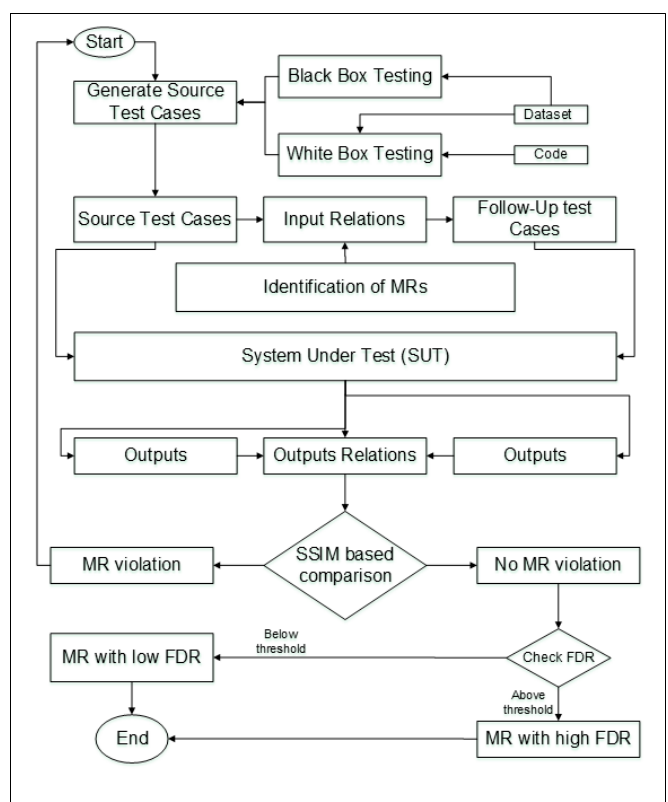
Figure 2. Proposed methodology.